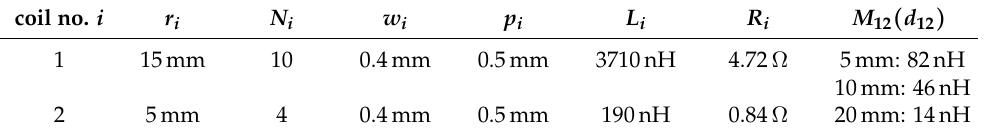
Table 1. Dimensions and characteristics of the used WPT coils, including outer radius r i , number of turns N i , trace width w i and trace pitch p i . The effective equivalent circuit parameters are provided for f = 40.68MHz, while maintaining the coil current uniform by capacitive segmentation [8]. coil no. i r